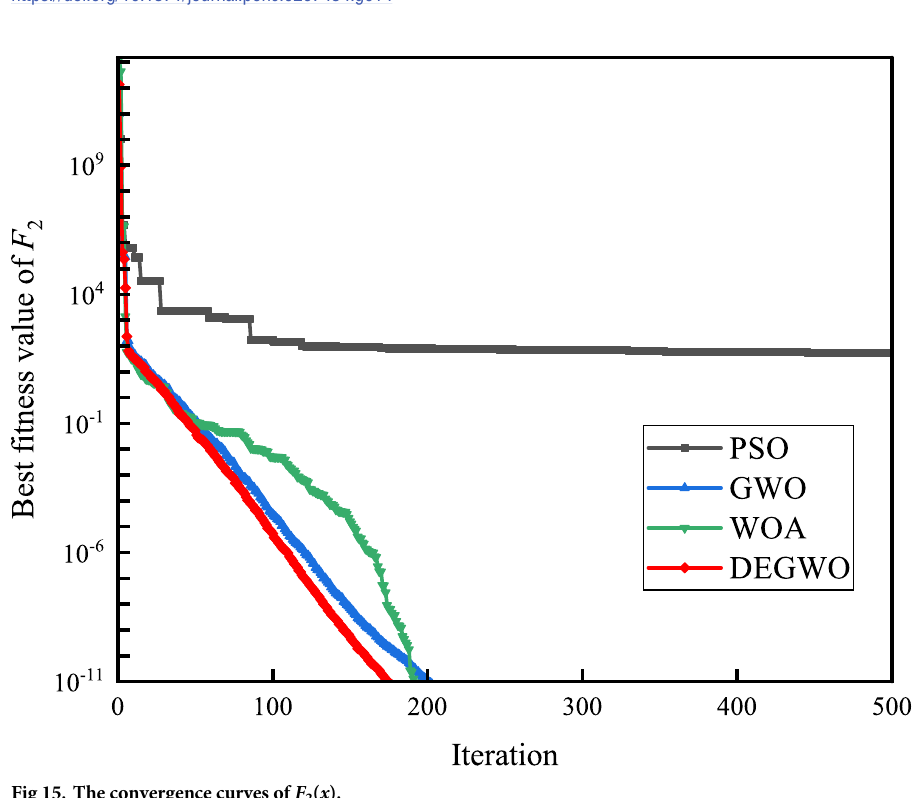
Fig 15. The convergence curves of F 2 ( x ).